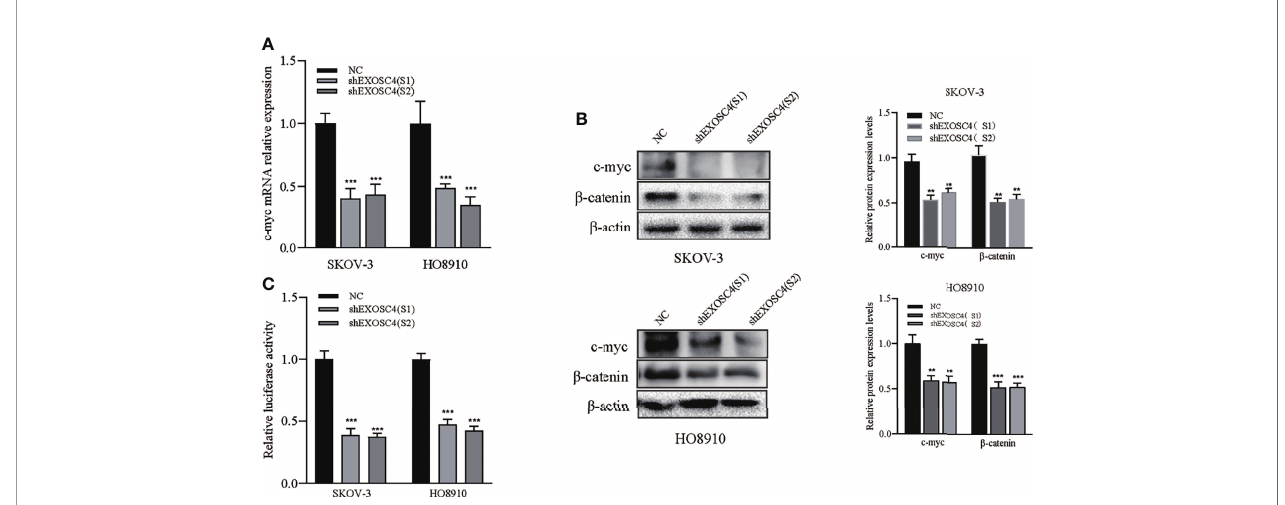
FIGURE 5 | Knockdown of EXOSC4 suppressed the Wnt signaling pathway. (A) mRNA levels of c-myc were detected using RT-PCR in SKOV-3 and HO8910 cells. (B) Western-blot assays to determine the protein levels of c-myc and b -catenin, and its band quanti fi cation. (C) The relative luciferase activity of TCF/LEF after EXOSC4 knockdown in SKOV-3 and HO8910 cells. **p < 0.01, ***p <